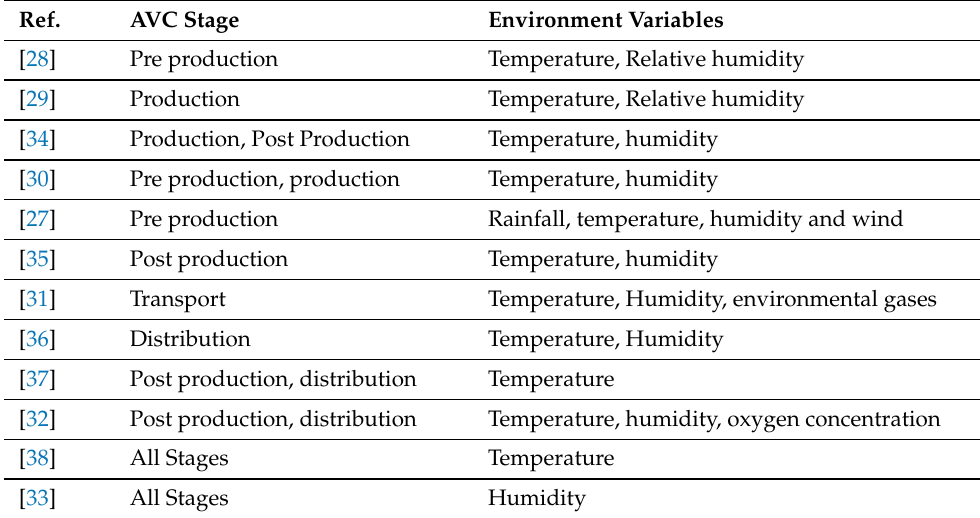
Table 1. Documents related to environmental variables in the agricultural value chain. Ref.